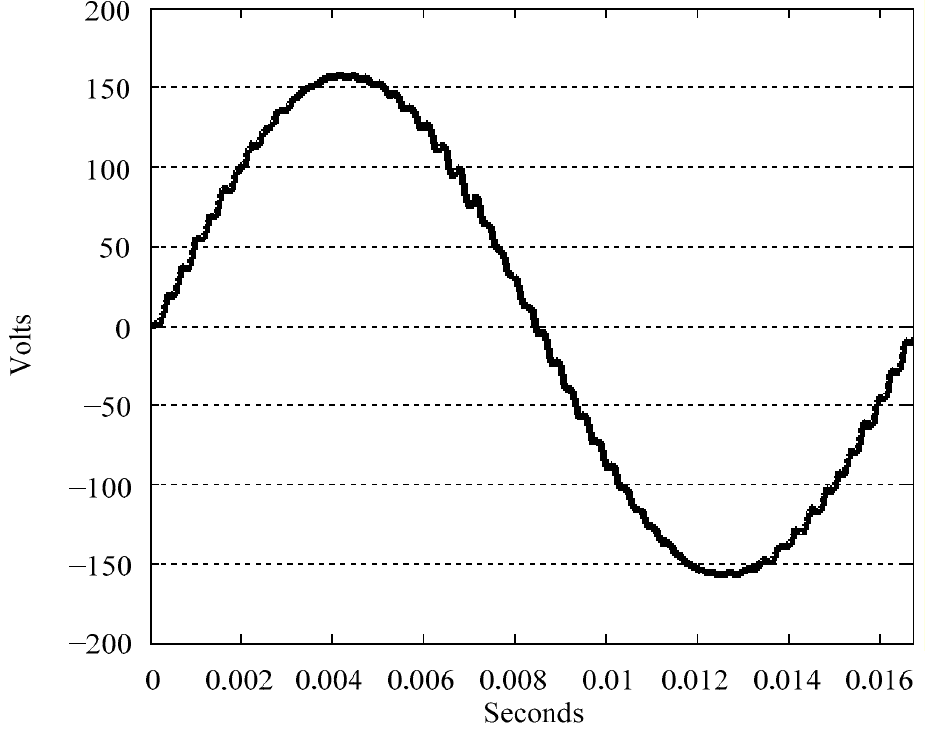
Figure 6. Simulated output voltage with the conventional SMC under LC parametric variations.